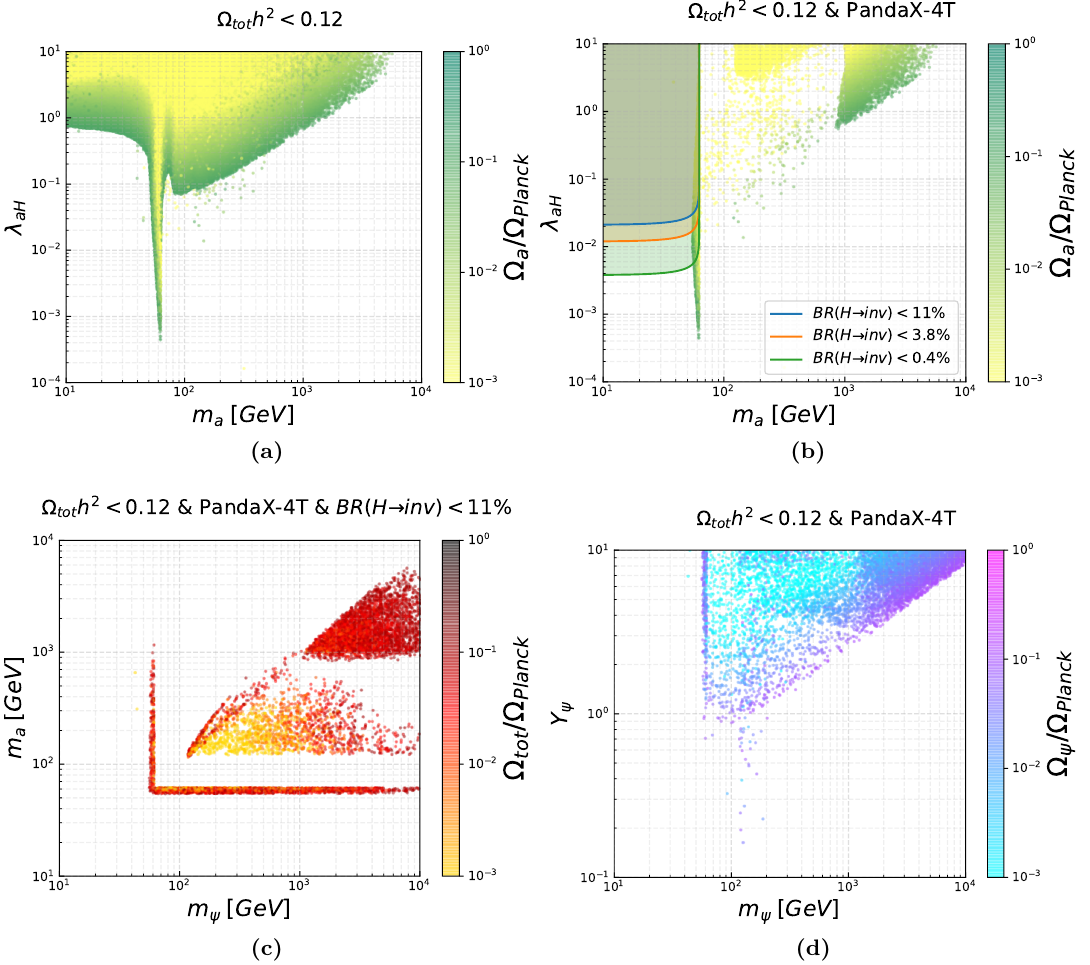
˜ (CP-odd) model (after con- F 0 S 0 0 0 Ω ), ψ ( Ω Ω ) or their sum ( Ω Ω ). a / PLANCK ψ / PLANCK tot / PLANCK are shown with colour corresponding to the PLANCK